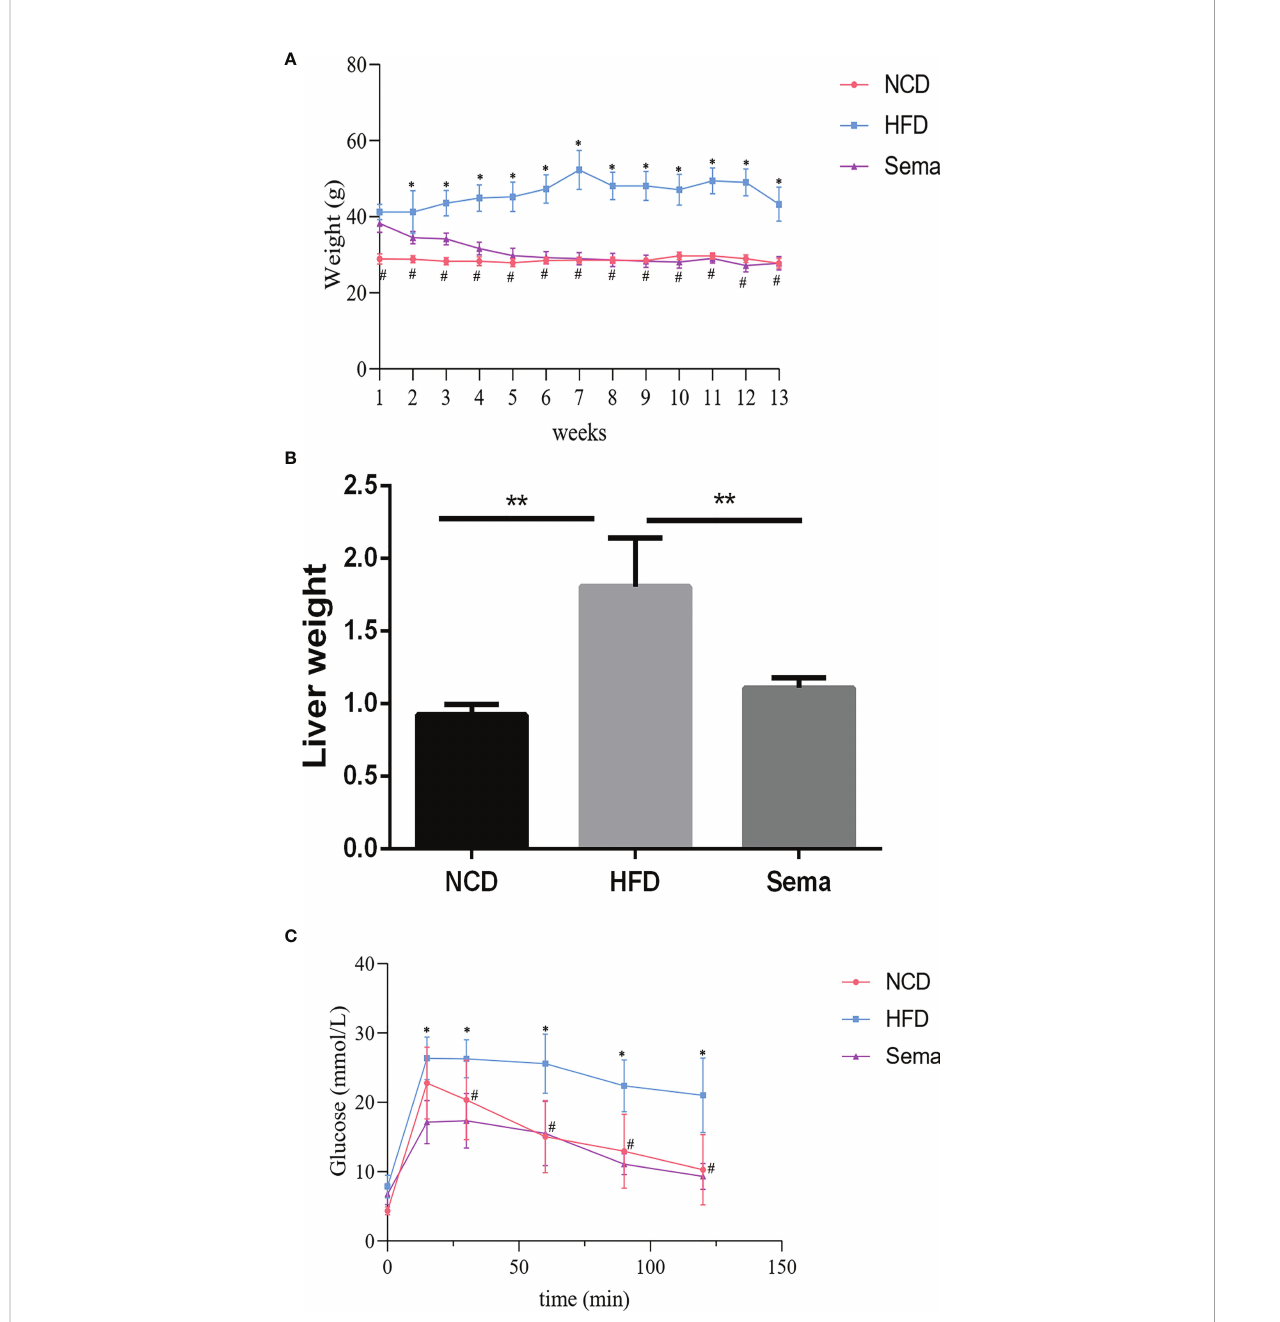
FIGURE 1 Semaglutide ameliorated HFD-induced obesity and blood glucose. (A) The body weight of NFD, HFD, HFD+sema group at the end of the 12th week of treatment was shown; (B) The liver weight of NCD, HFD, HFD+sema group at the end of the 12th week of treatment was shown; (C) Glucose tolerance was determined by IFGTT test; NCD, normal diet; HFD, high-fat diet; sema, semaglutide; IPGTT, Intraperitoneal glucose tolerance test. # means HFD vs Sema; * means NCD vs